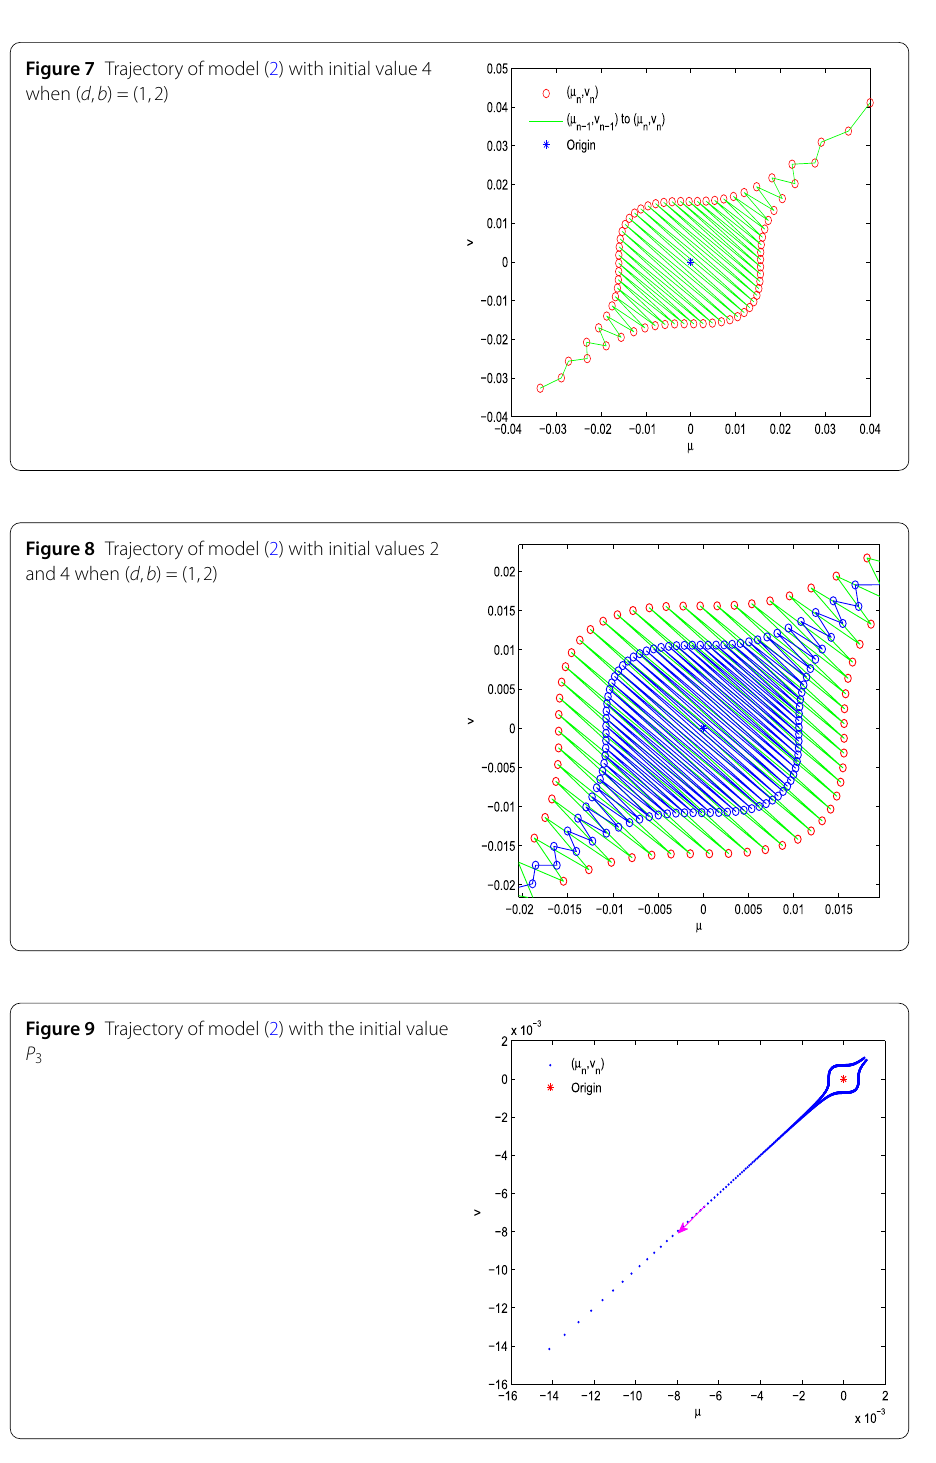
10 –5 ,1.109748 × 10 –5 ), and the trajectory of model (2) with initial value P 2 near the fixed point (0,0) is shown in Fig.